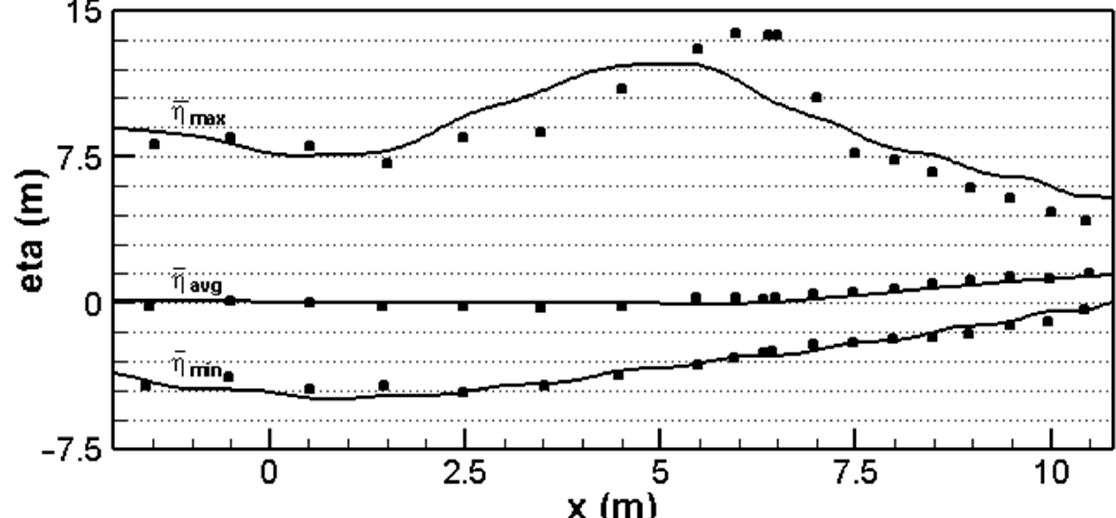
Figure 5. Results 1: minimum, average and maximum water surface elevations in Configuration TS, showing numerical results (solid line) and experimental measurements (circles).